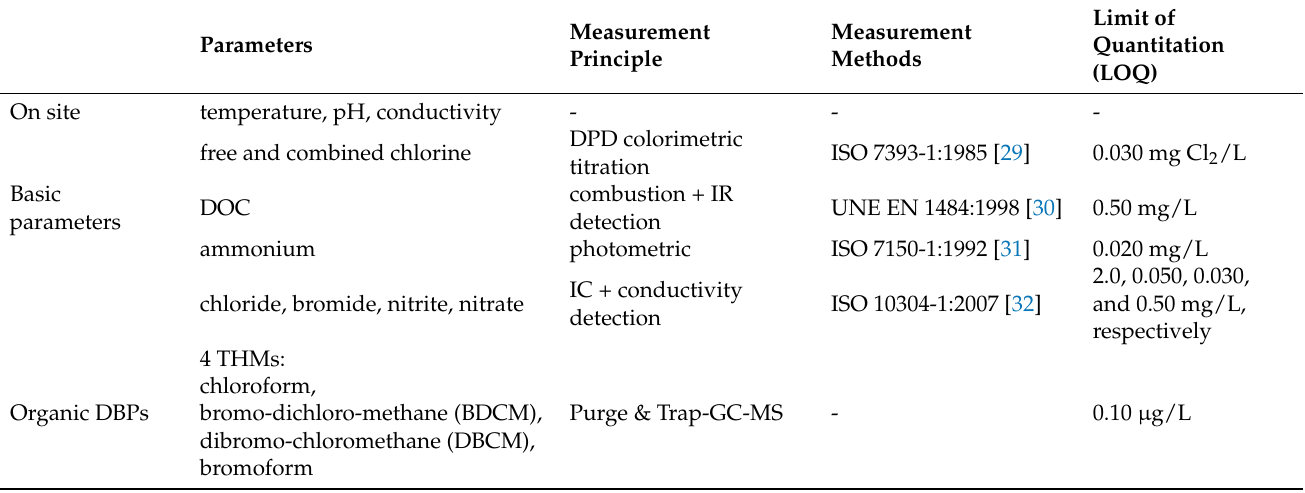
Table 1. Analyzed parameters during field sampling and bench-scale